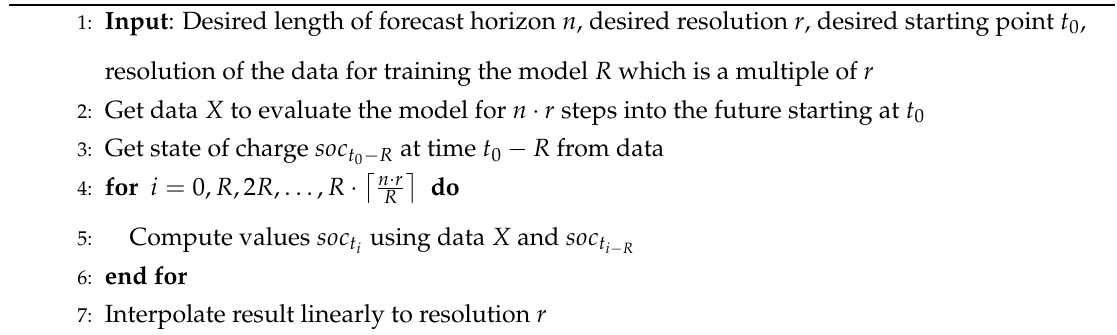
Algorithm 2: Iterative forecast